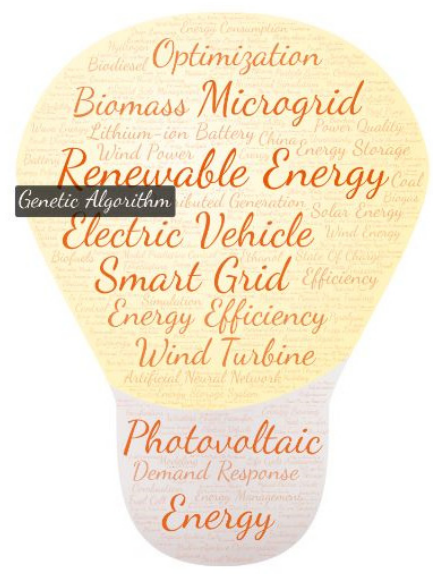
Figure 10. Representation of the most globally representative Figure 10 . Representation of the most globally representative keywords.